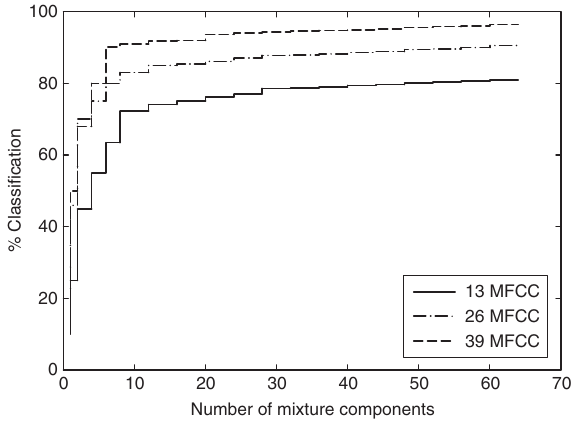
Figure 3: Dysfluency Classification Performance for Different Mixtures and Parameters.